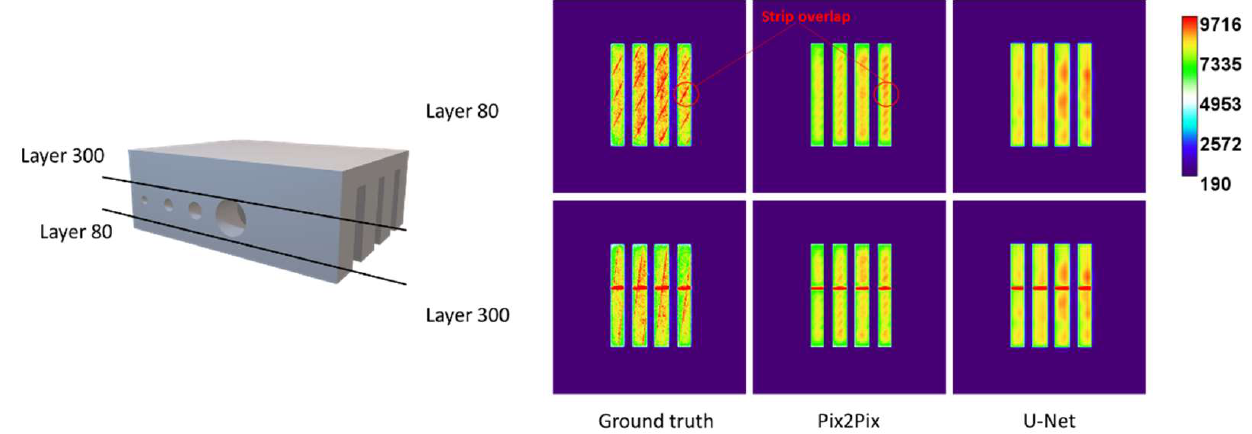
Figure 8. Test results of layer 80 and layer 300 for different network structures.